Question: Sum up the contents of this chart in one sentence.
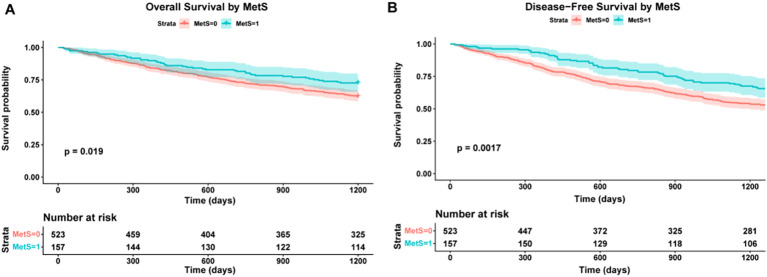
Answer: Kaplan-Meier survival analysis stratified by metabolic syndrome (MetS) status. (A) overall survival (OS); (B) disease-free survival (DFS).